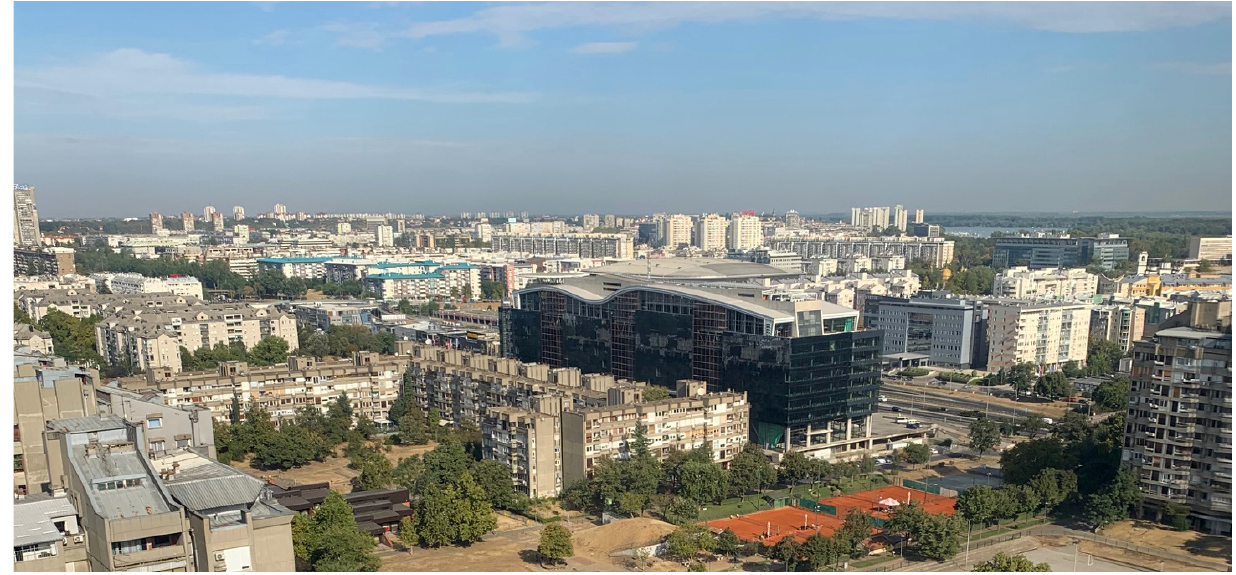
Figure 10. New Belgrade in 2020. Source: Anica Dragutinovic (photograph taken by Zorana Jovic for the student workshop “Reuse of Common Spaces of New Belgrade Blocks: Co‐designing the Urban Commons,” Belgrade, September